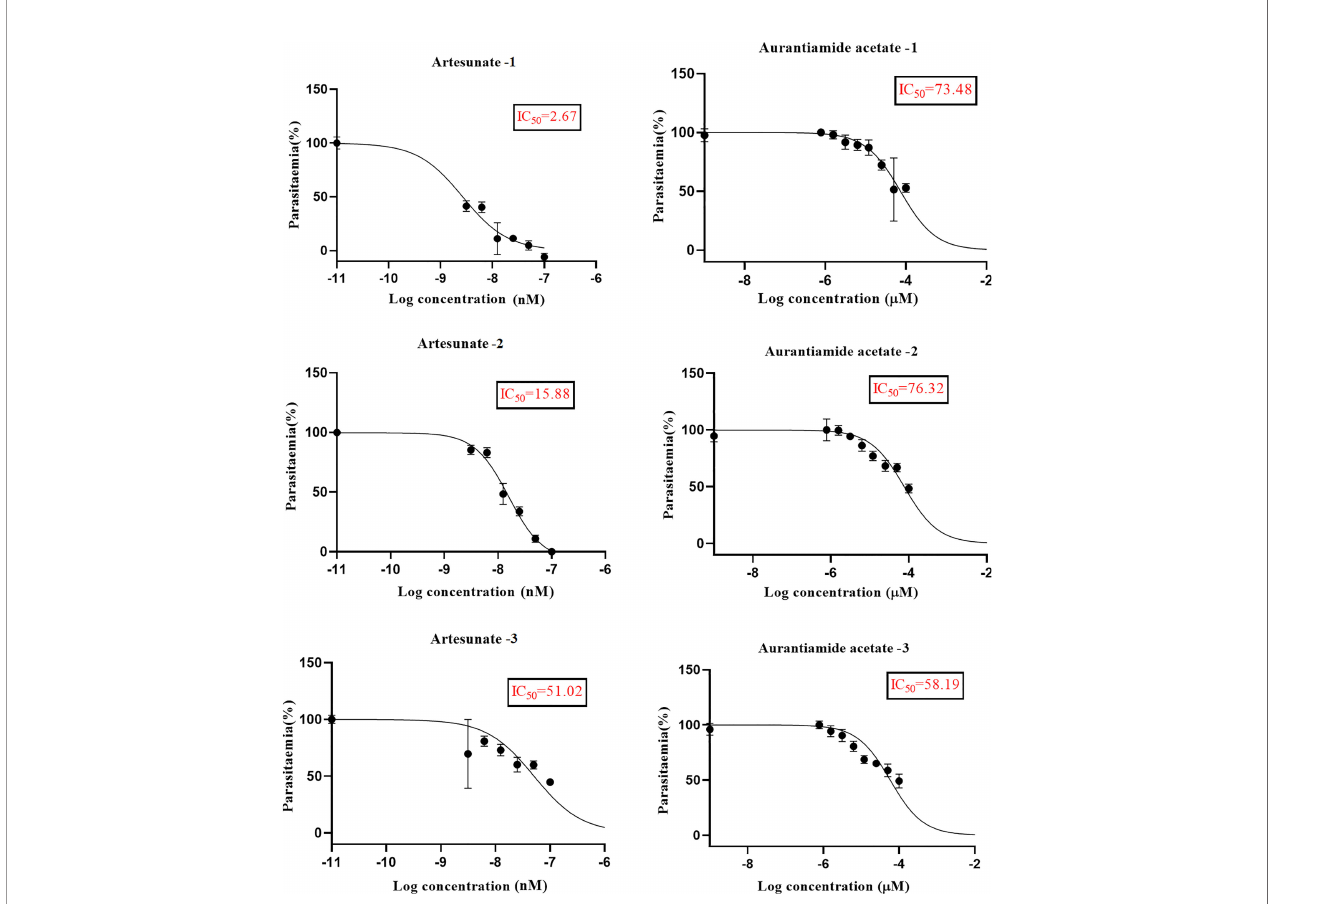
FIGURE 7 | The inhibition curves of artesunate and aurantiamide acetate for the synchronized culture of Plasmodium falciparum 3D7 ring stages.